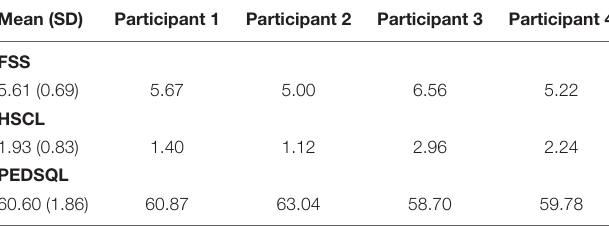
TABLE 3 | Descriptive statistics of self-reported psychosocial health.